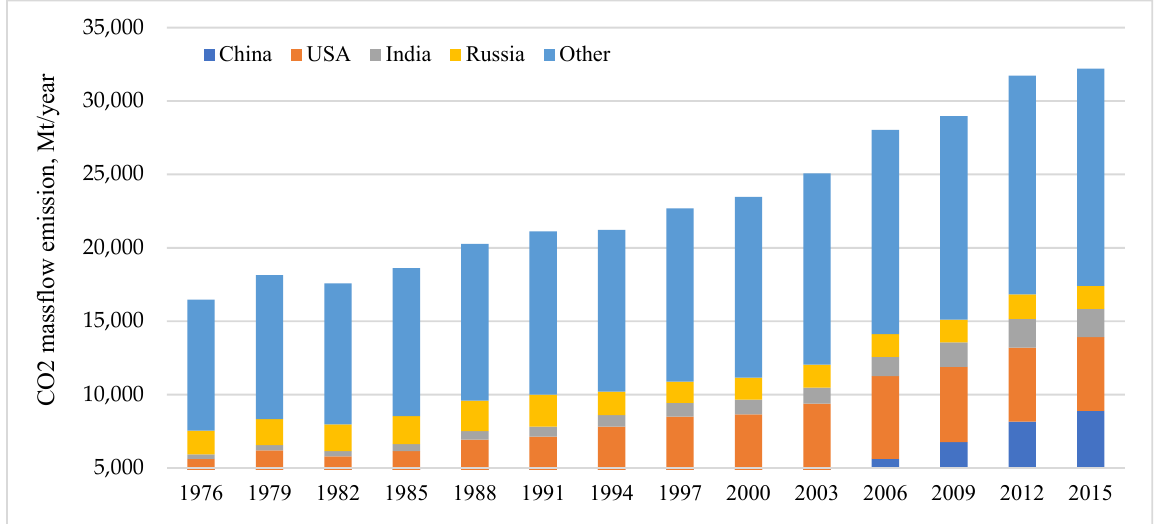
Figure 2. Carbon dioxide emissions by country.